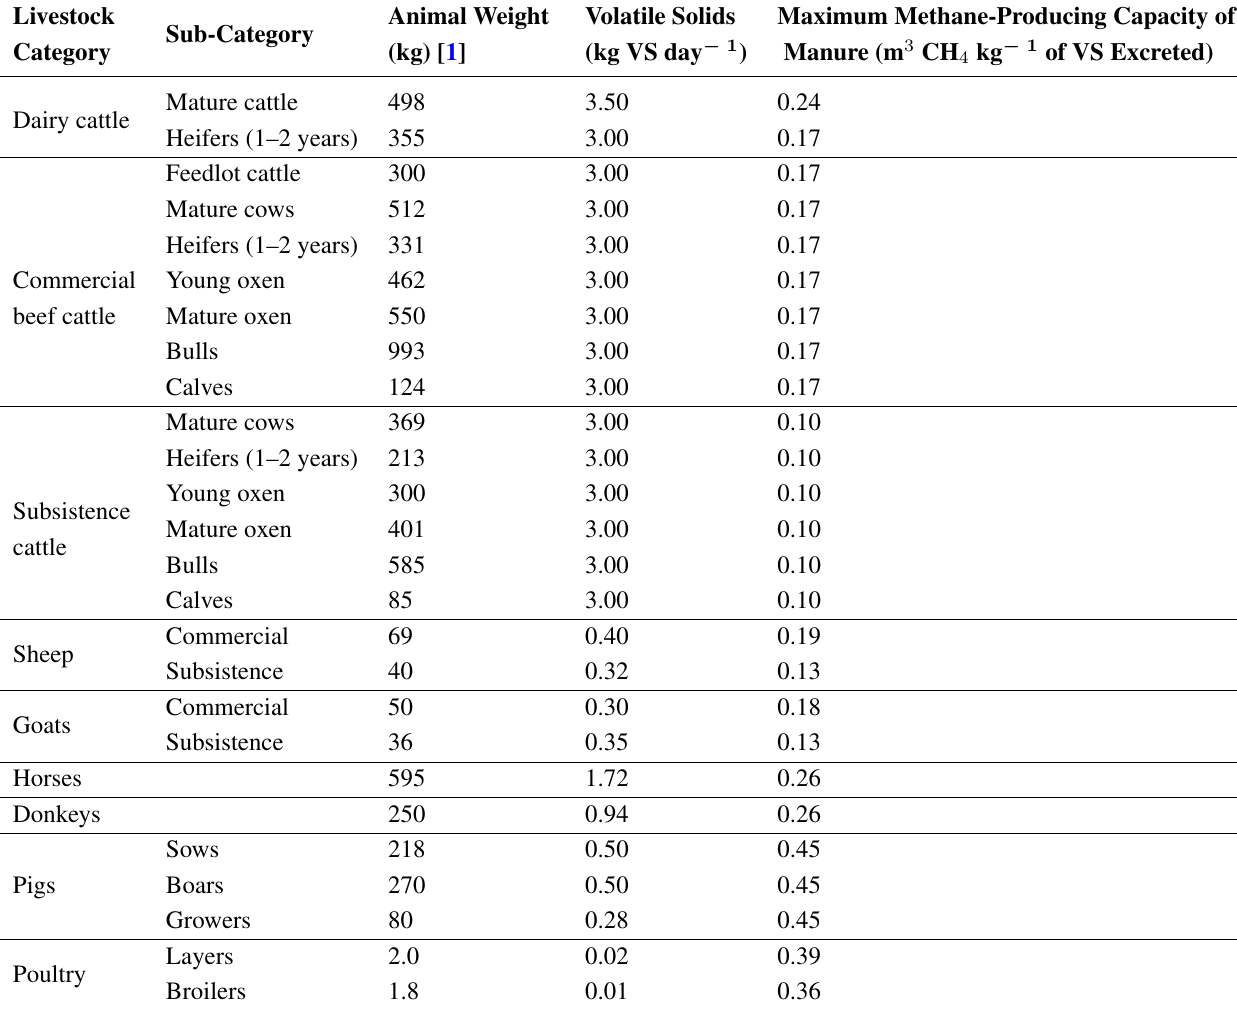
Table 2. Productivity data for all the livestock